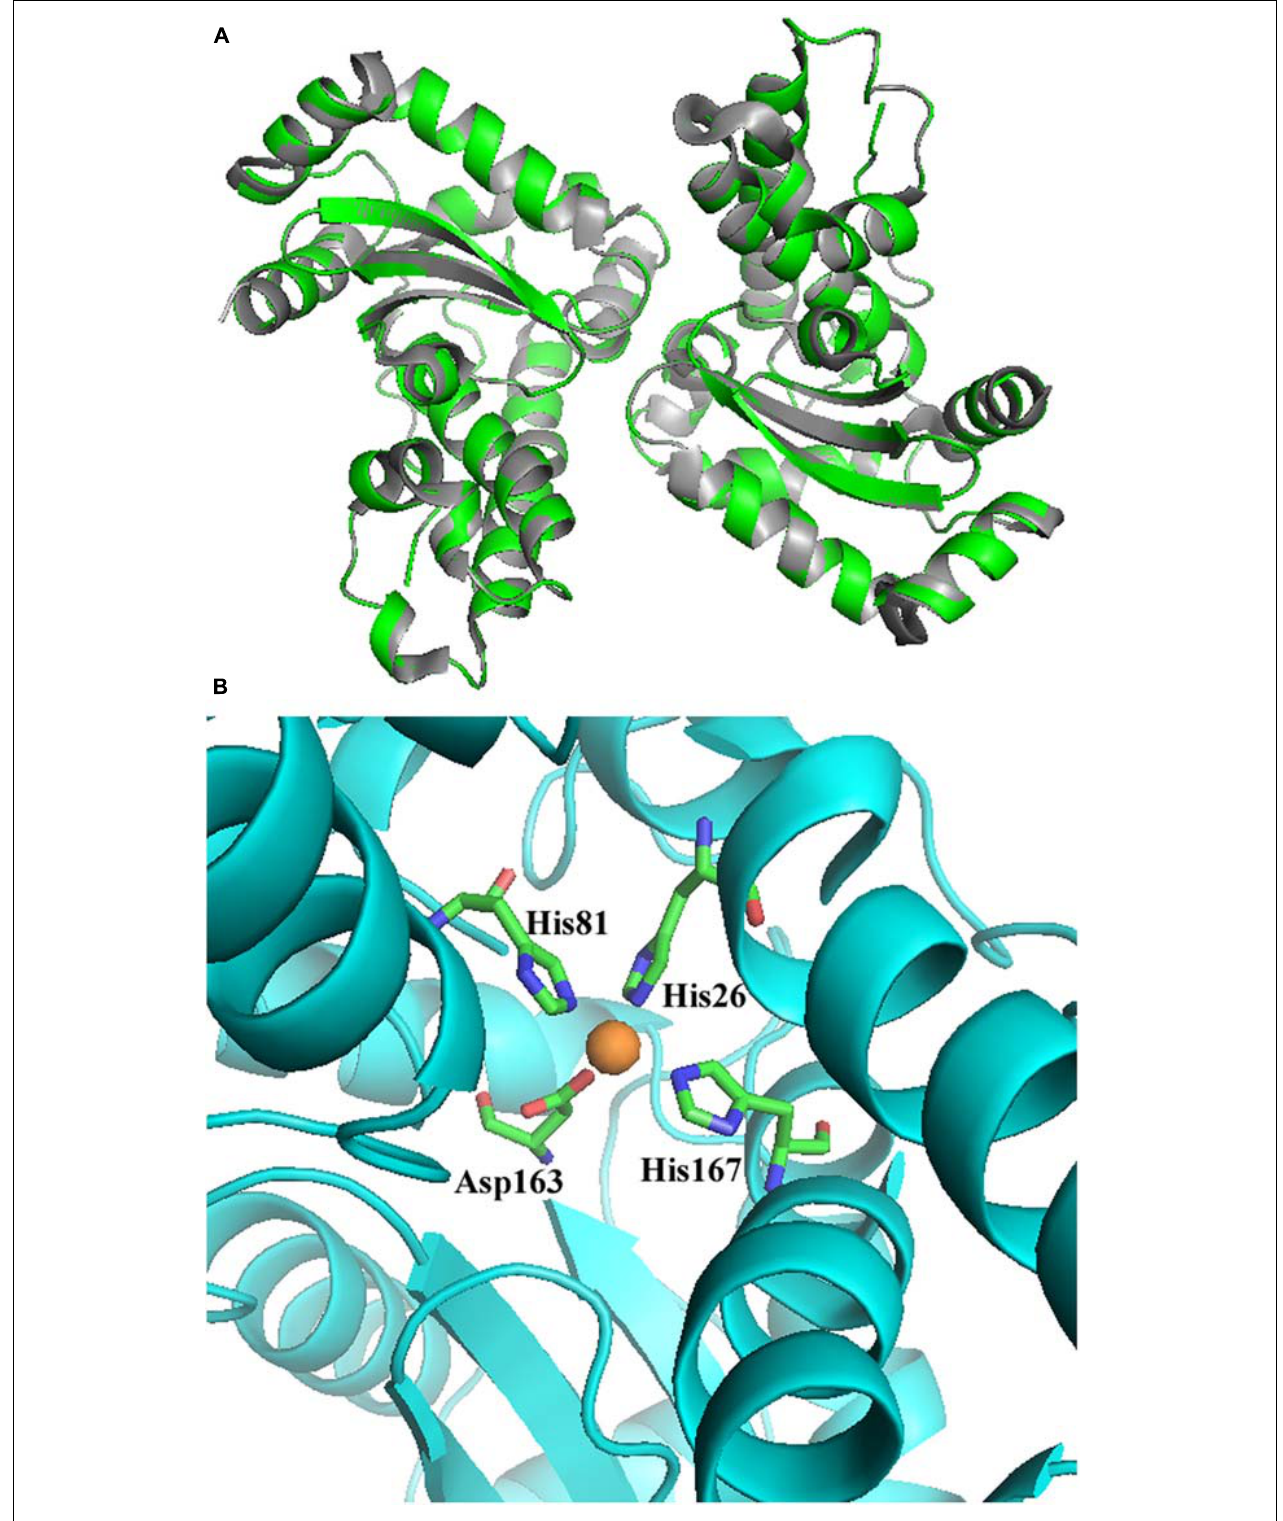
FIGURE 3 | Superimposition of the predicted structure of Aa SOD (Green) over its template of Geobacillus stearothermophilus Gs -MnSOD (gray) (A) and four predicted residues for manganese binding (B) .